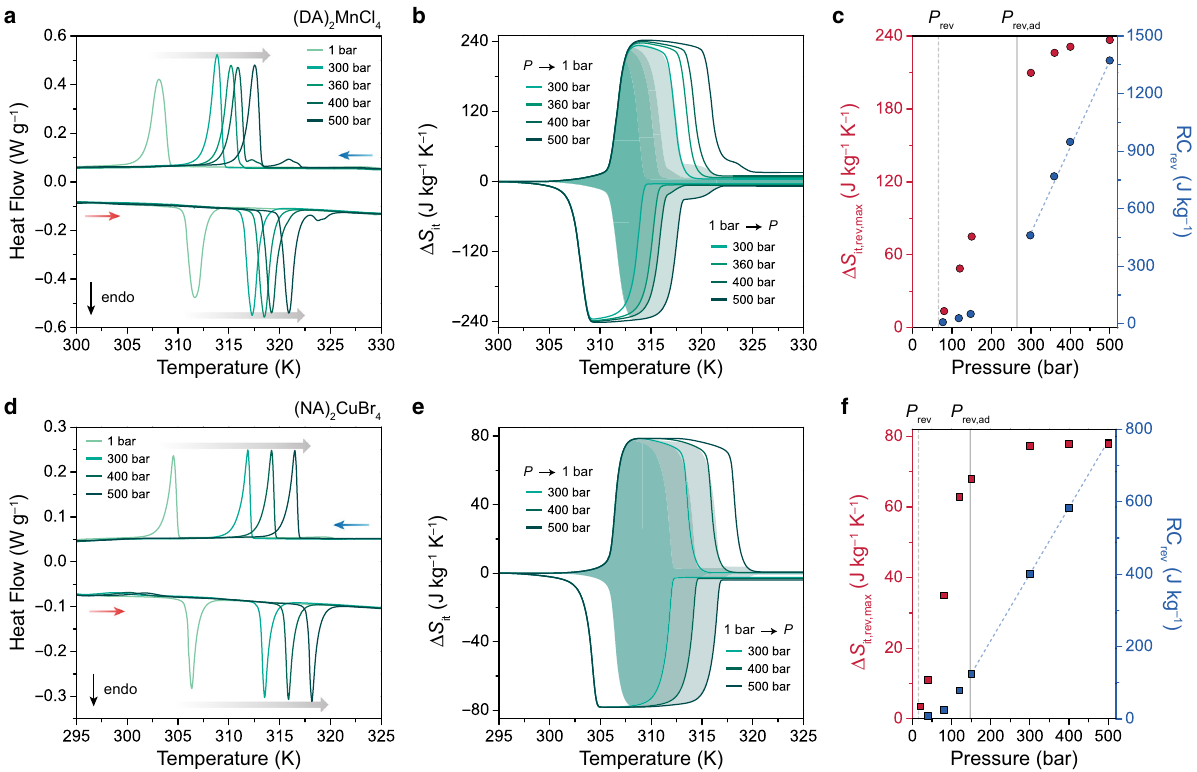
Fig. 5 Isobaric DSC experiments from 300 – 500 bar. DSC measurements under applied hydrostatic pressure for powder samples of ( a ) (DA) 2 MnCl 4 and ( d ) (NA) 2 CuBr 4 up to 500 bar, with heating and cooling rates of 0.5 K min – 1 . Note that He was used as the pressure-transmitting medium. Isothermal entropy changes ( Δ S it ) calculated by the quasi-direct method for ( b ) (DA) 2 MnCl 4 and ( e ) (NA) 2 CuBr 4 . The shaded area indicates the reversible Δ S it within this pressure range. Maximum reversible isothermal entropy change ( Δ S it,rev,max ) and reversible refrigeration capacity (RC rev ) for ( c ) (DA) 2 MnCl 4 and ( f ) (NA) 2 CuBr 4 as a function of operating pressure, with the minimum pressures required to induce a reversible isothermal entropy change ( P rev ) and a reversible adiabatic temperature change ( P rev,ad ) marked using vertical lines. Note that Δ S it,rev,max is equivalent to the peak value of each reversible isothermal entropy curve, and RC rev is calculated as Δ S it,rev,max × Δ T FWHM . The dependence of RC rev on operating pressure above P rev,ad is highlighted using blue dashed lines. The pressure dependence of RC rev is 4524 J kbar – 1 kg – 1 and 1830 J kbar – 1 kg – 1 for (DA) 2 MnCl 4 and (NA) 2 CuBr 4 , respectively.